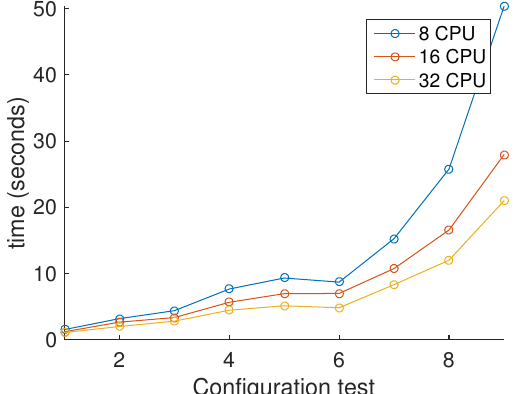
Figure 11. Comparative performance between parallel versions using 8, 16 and 32